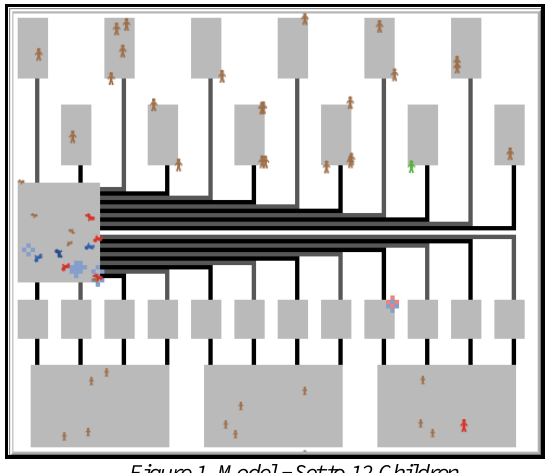
Figure 1 . Model - Set to 12 Children Interactive buttons (Table 2) on the interface include: “Setup!”, “Go!”, “Go!” (Loop), and “Clear